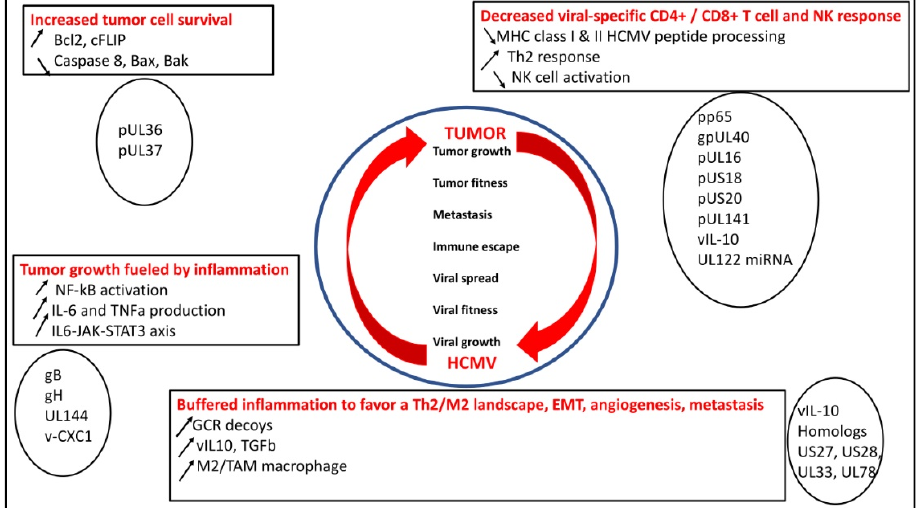
Figure 1. HCMV rewires the immune landscape to favor both HCMV fitness and tumor growth through several mechanisms: increased tumor cell survival, tumor growth fueled by inflammation parallel to the appearance of an M2/Th2 immune landscape, and escape from immune surveillance by decreased specific CD4 + /CD8 + T-cell and NK responses.